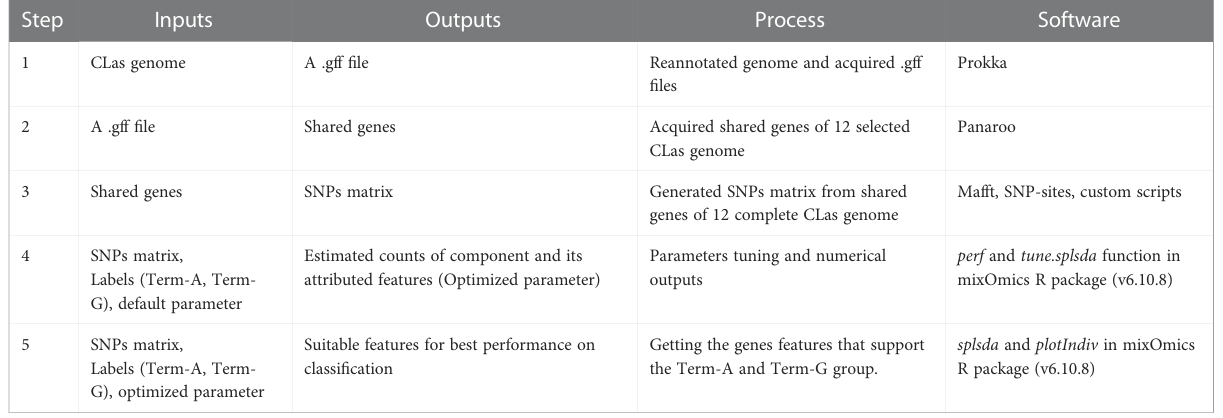
TABLE 2 A work fl ow of sparse partial least-squares discriminant analysis (sPLS-DA) in this